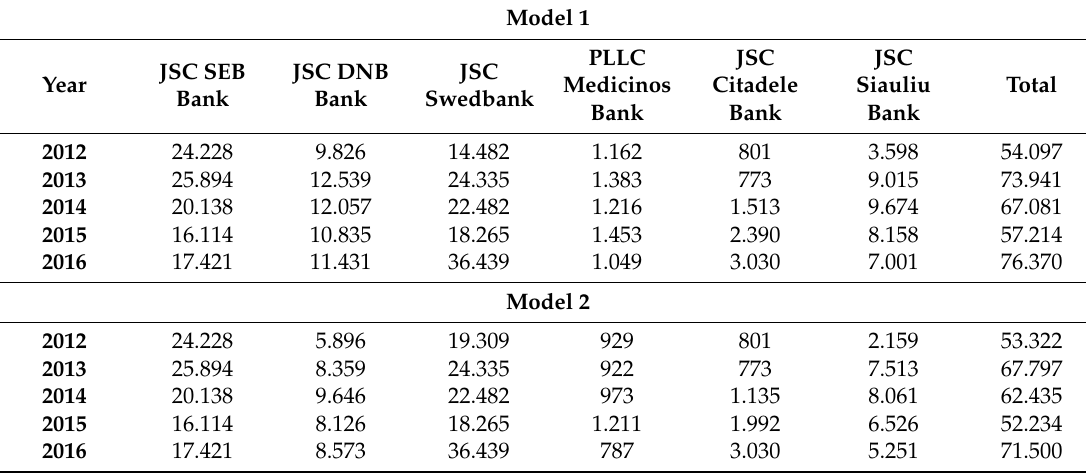
Table 7. The setting of sizes of annual contributions in Lithuanian banks excluding systemic risk (Model 1) and including systemic risk (Model 2) in thousands of